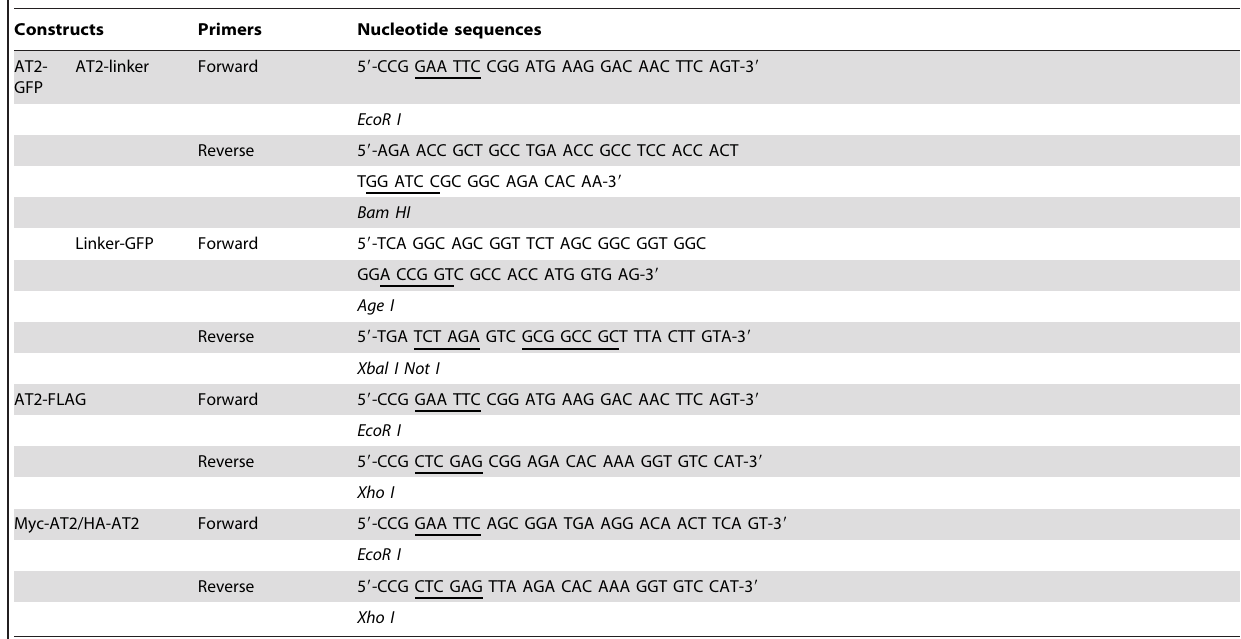
Table 1. PCR primers for rat At2 cDNA sublconing.